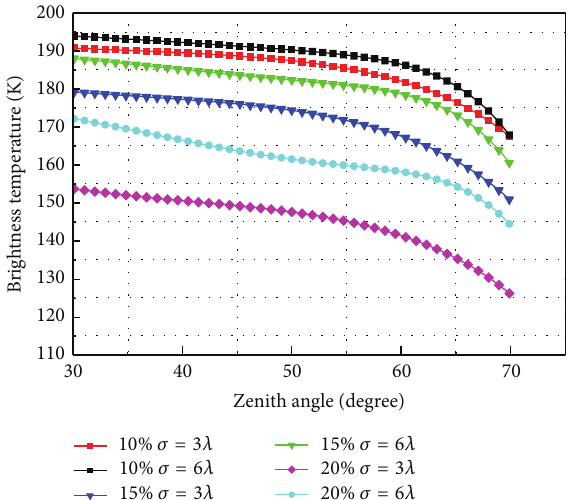
Figure 19: Comparison of different correlation lengths of wet soil with different moisture content, in which the root mean square height is 3 𝜆 , and the relative complex permittivity of 10% humidity, 15% humidity, and 20% humidity is set as 2.1- j 0.9, 3.0- j 1.23, and 1.73- j